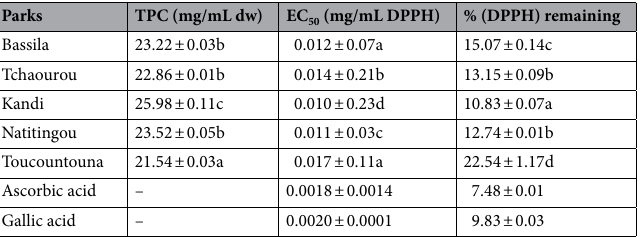
Table 6. Parameters of free radical scavenging activity by DPPH and total phenolics of P. butyracea fruit pulp by park. Mean ± Standard deviation; values with the same letter in the same column, are not significantly different at p <